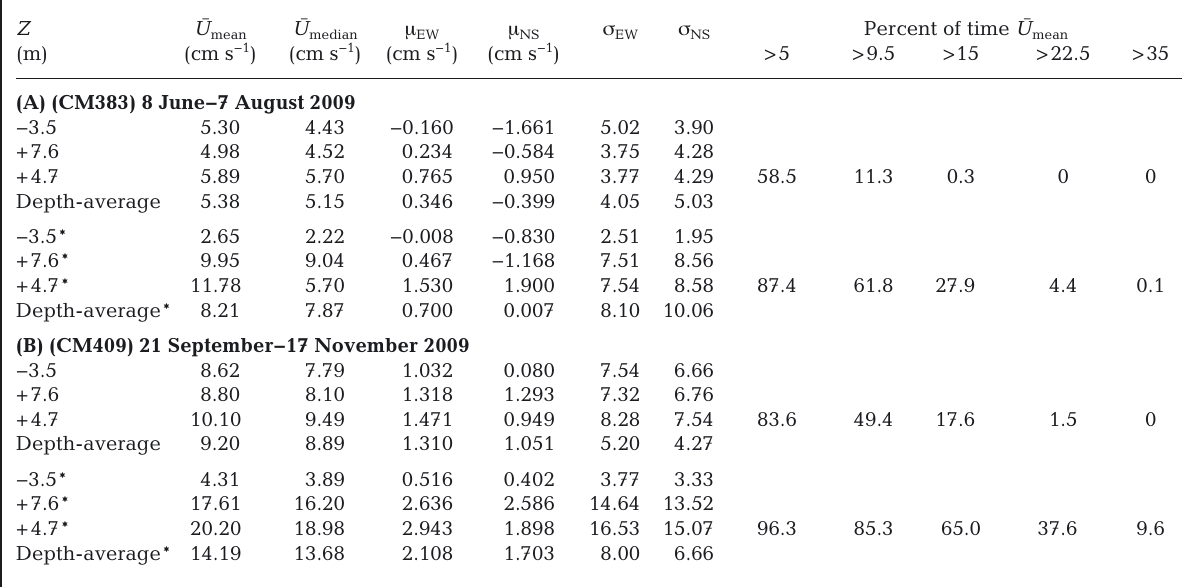
Table 2. Depth ( Z ; −: below surface; +: above bottom), mean and median current speed (U ⁻ ) , mean ( μ ) and standard deviation ( σ ) for east−west (EW) and north−south (NS) velocity components and the percent of time near-bottom U ⁻ mean (cm s –1 ) exceeded thresholds obtained from 2 bottom-moored acoustic Doppler current profilers (ADCP) (CM383 and CM409) for 2 time periods at Farm A (Fig. 1) in Bliss Harbour in 2009 (data summarized from Chang et al. 2014a). Depth averages are for near-surface, mid- and near-bottom depths. (*) indicates u and v near-surface velocities decreased (×0.5) and mid- and near-bottom velocities increased (×2) to account for side-wall drag effects within and under the net-pen array (Wu et al. 2014). Frequency distribu- tions for μ and σ velocity values are shown in Fig.